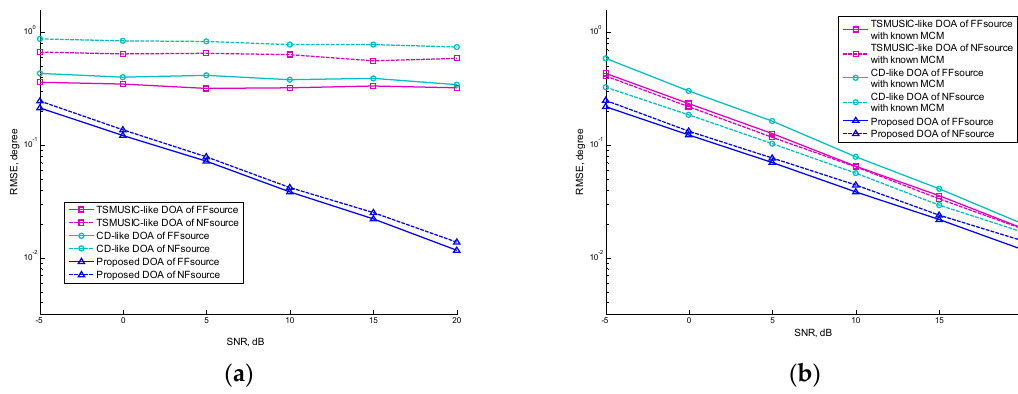
Figure 7. ( a ) RMSEs of the DOA estimates versus signal noise ratio (SNR); ( b ) RMSEs of the DOA estimates versus SNR with known MCM.